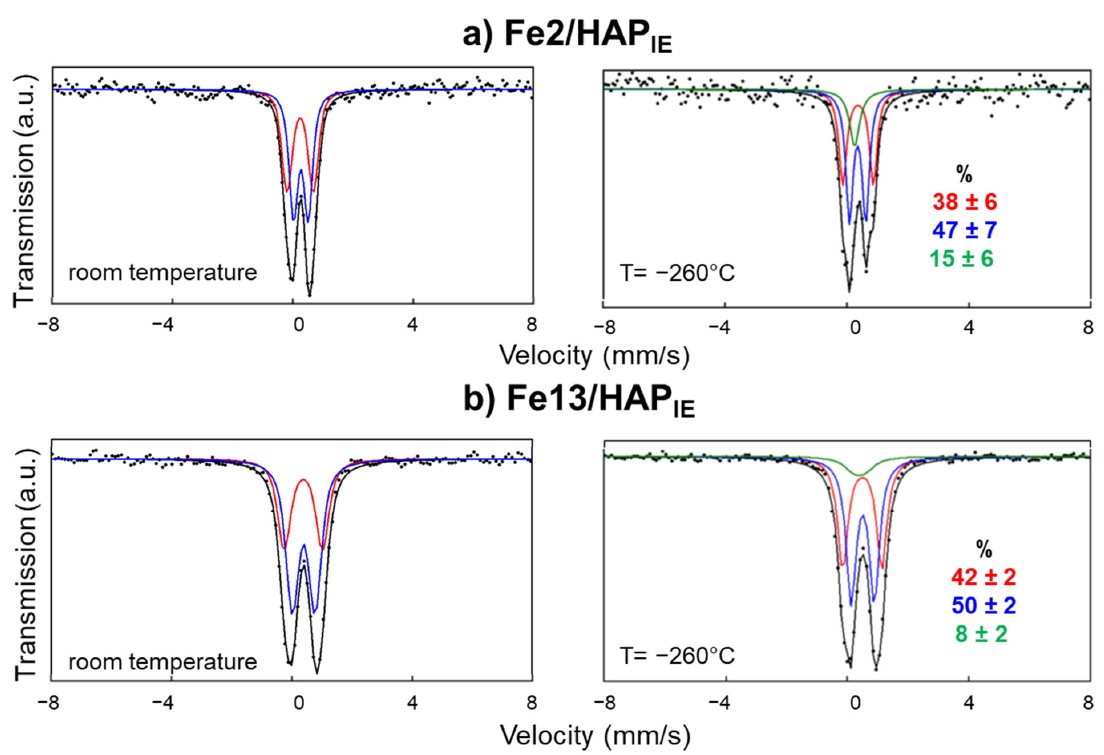
Figure 6. Mössbauer spectra of two Fe / HAP samples, presenting the lowest and the highest Fe-loading Figure 6 . Mössbauer spectra of two Fe/HAP samples, presenting the lowest and the highest Fe- among Fe-loaded samples (Fe2 / HAP IE , ( a ), and Fe13 / HAP IE , ( b ), respectively), chosen as representative loading among Fe-loaded samples (Fe2/HAP IE , (a), and Fe13/HAP IE , (b), respectively), chosen as sample, collected at room temperature (left) and at − 260 ◦ C (right). Percentage values indicate the representative sample, collected at room temperature (left) and at − 260°C (right). Percentage values normalized population of Fe 3 + indicate the normalized population of Fe 3+ centers.